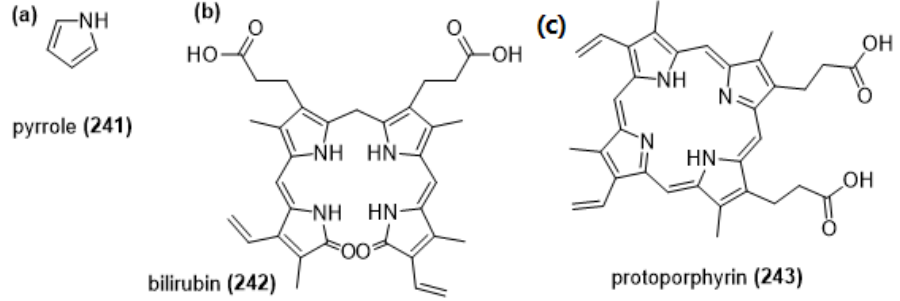
Figure 17. Structures of pyrrole ( a ), bilirubin ( b ), and protoporphyrin ( c